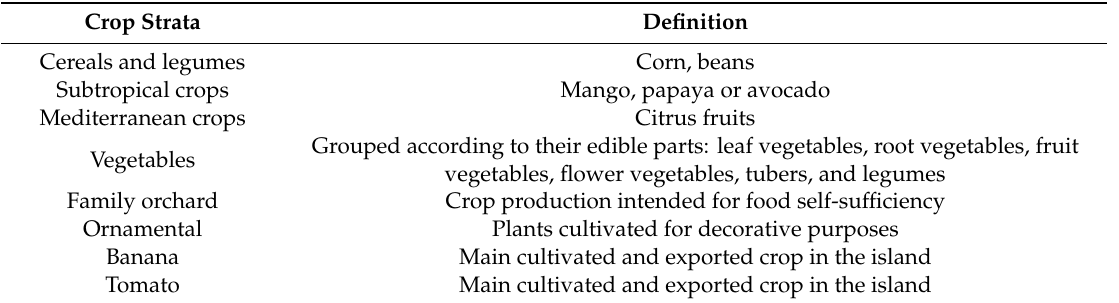
Table 1. Crop strata and its definition.